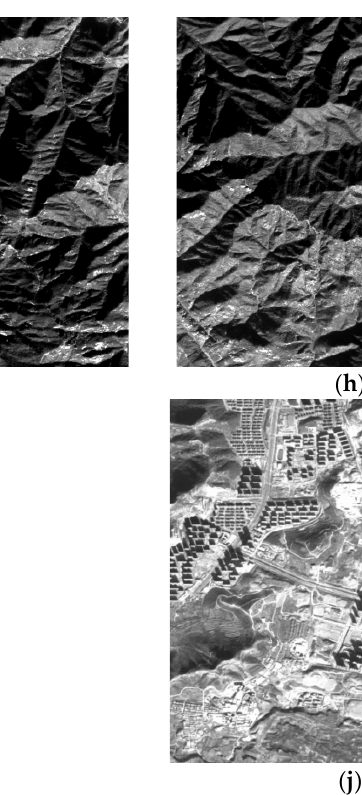
Figure 6. The original image of ten regions: ( a ) valley region 1; ( b ) valley region 2; ( c ) valley region 3; ( d ) ridge region 1; ( e ) ridge region 2; ( f ) region 3; ( g ) peak region 1; ( h ) peak region 2; ( i ) peak region 3; and ( j ) urban region 1.